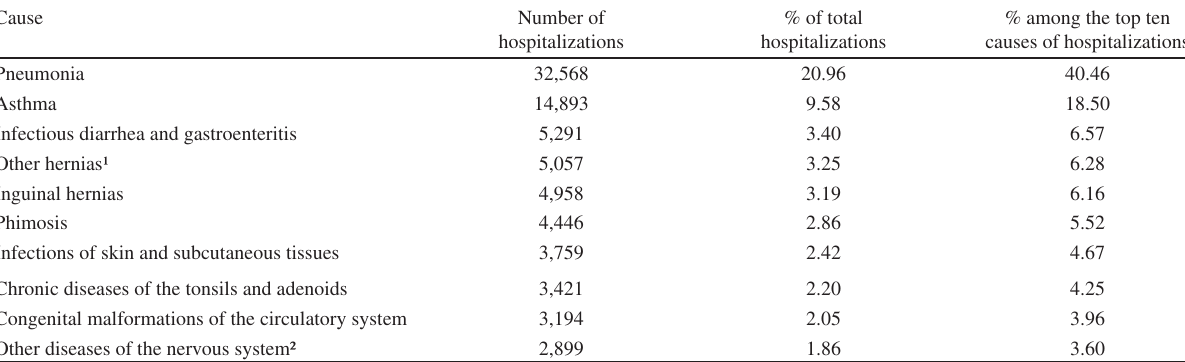
Table 3 - The top ten main causes of hospitalization in children between one to four years old in the district city of São Paulo, during the five years studied, 2002 to